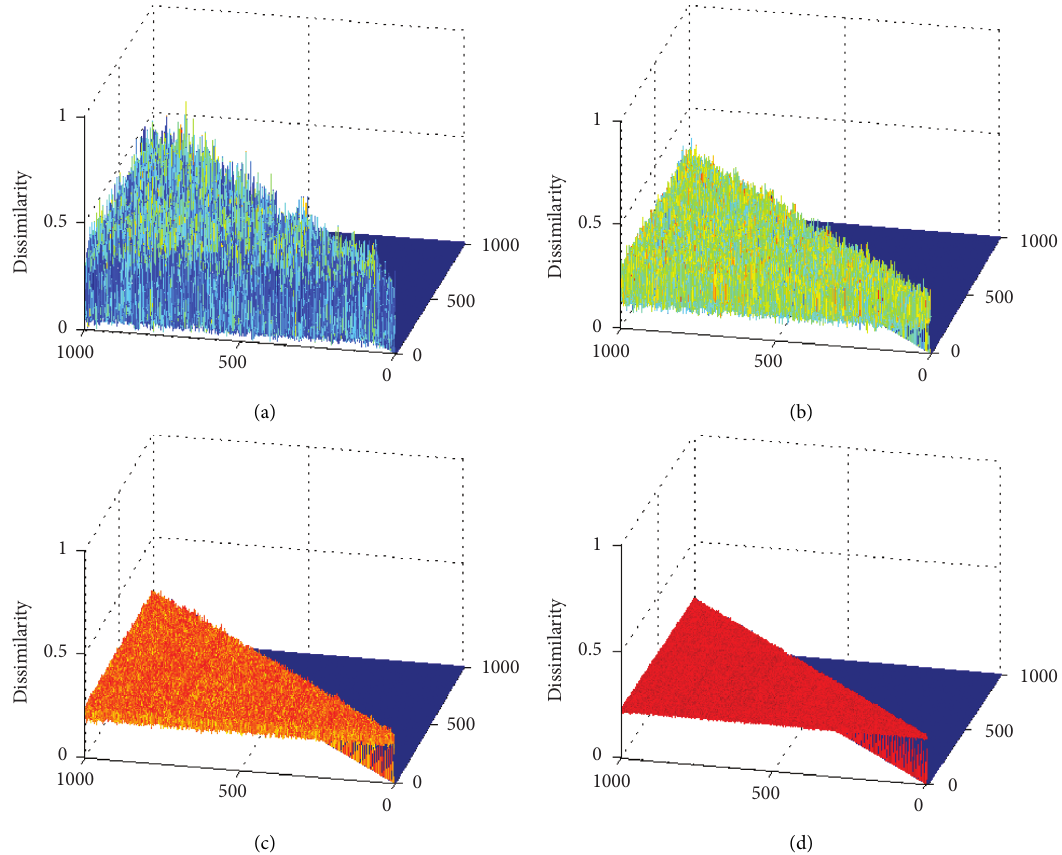
Figure 15: Dissimilarity matrix for a constant message: (a) message length � 25bytes; (b) message length � 100bytes; (c) message length � 1000; (d) message length �